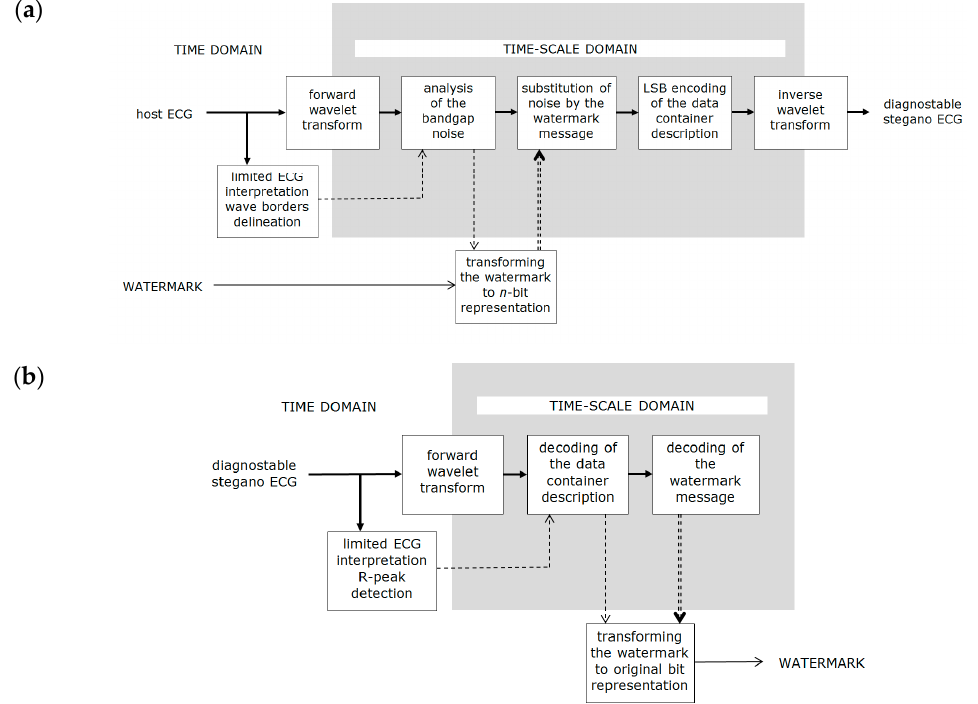
Figure 2. Irreversible watermarking process ( a ) watermark embedment; ( b ) watermark extraction.